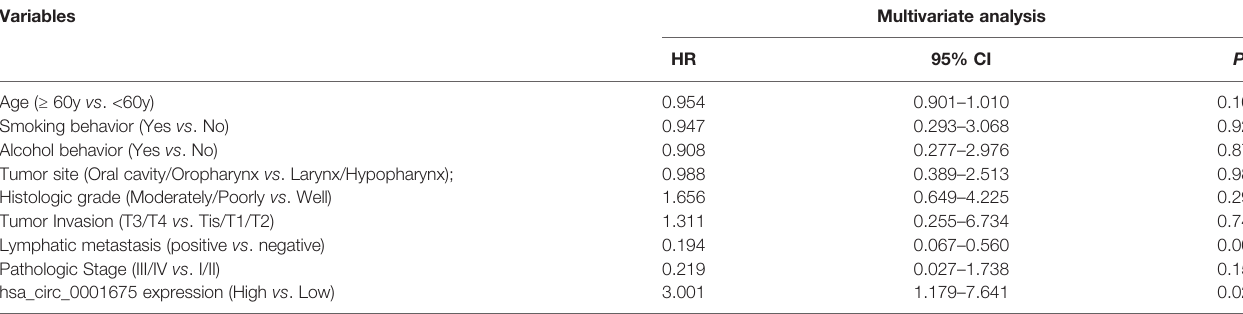
TABLE 2 | Multivariate Cox regression analysis of prognostic factors affecting disease-free survival in HNC patients.